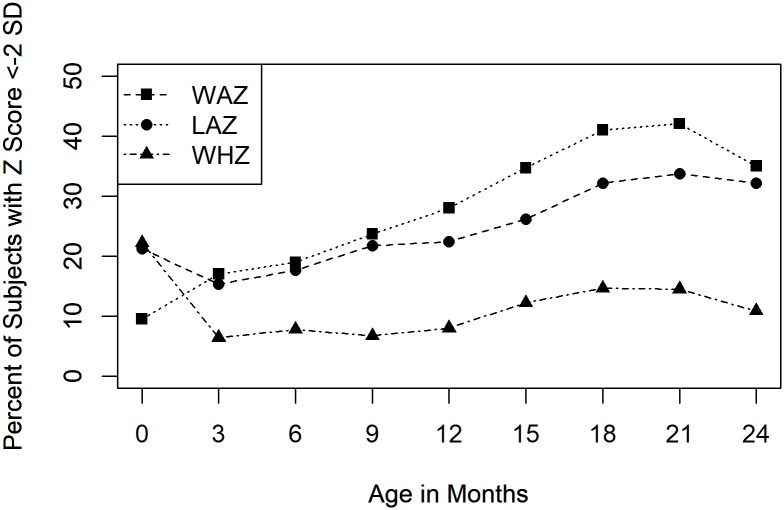
Anthropometry over the first 2 years of life for the 371 children with complete anthropometric measurements.Height and weight were taken at 3-month intervals and transformed to standardized Z scores. The X-axis depicts the child’s age while the Y-axis depicts the percentage of children in the cohort who had a LAZ, WAZ, or WHZ <-2 SD.